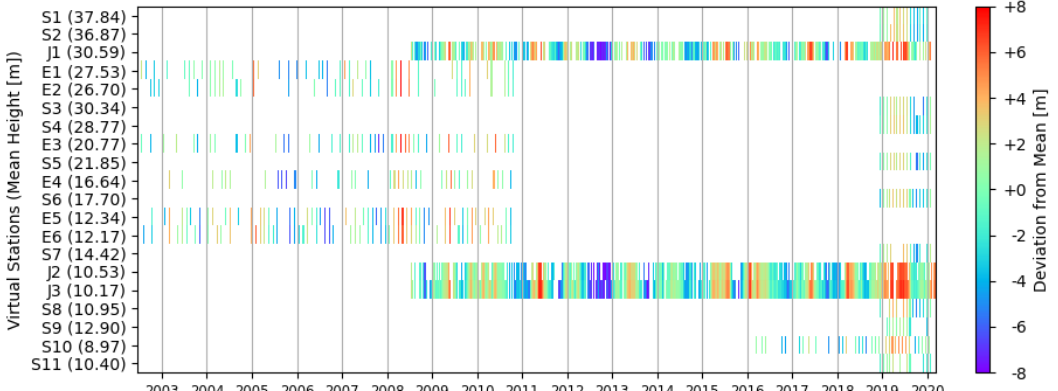
Figure 2. Measured height anomalies for each virtual station. The mean height per station is provided in brackets at the